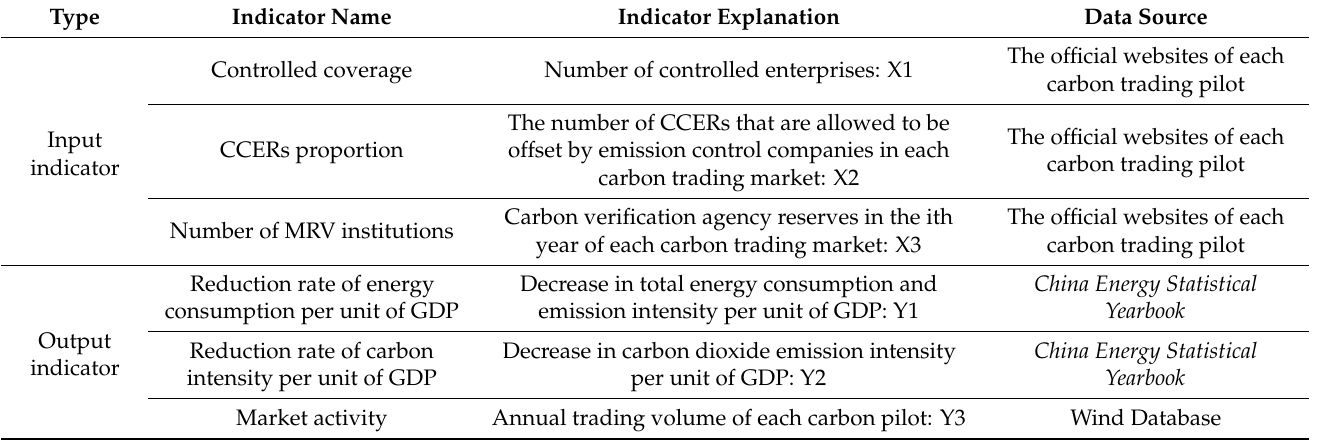
Table 1. The efficiency rating indicator system of the carbon trading